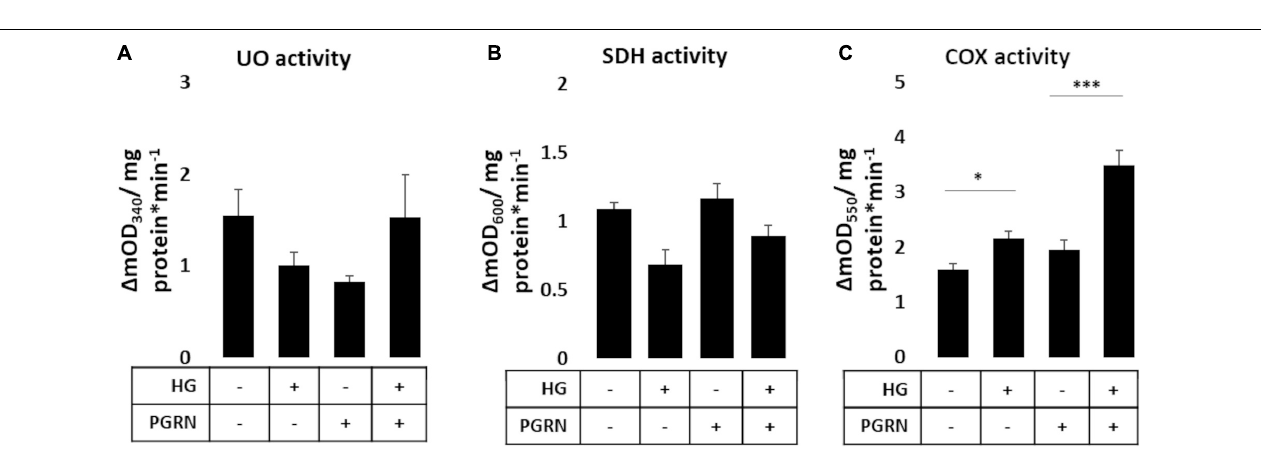
FIGURE 6 | Mitochondrial complex activity in primary cortical neurons in response to high glucose and PGRN. Cells were treated with high glucose and PGRN for 72 h before harvest and enzymatic testing via microplate assay. (A) Ubiquinone oxidoreductase (UO) activity was unchanged among treatment conditions. (B) Succinate dehydrogenase (SDH) activity decreased under high glucose from 1.138 ± 0.069 (cid:49) mOD 600 to 0.817 ± 0.172 (cid:49) mOD 600 . While PGRN alone did not alter activity (1.203 ± 0.026 (cid:49) mOD 600 ), it attenuated the decrease in activity due to high glucose (1.069 ± 0.129 (cid:49) mOD 600 ). N = 6 samples. (C) Cytochrome C oxidase (COX) activity was increased by high glucose from 1.596 ± 0.100 (cid:49) mOD 550 to 2.167 ± 0.122 (cid:49) mOD 550 . With PGRN, high glucose amplified this increase from 1.948 ± 0.183 (cid:49) mOD 550 to 3.482 ± 0.274 (cid:49) mOD 550 . N = 5-6 samples. ∗ p < 0.05; ∗∗∗ p < 0.001.